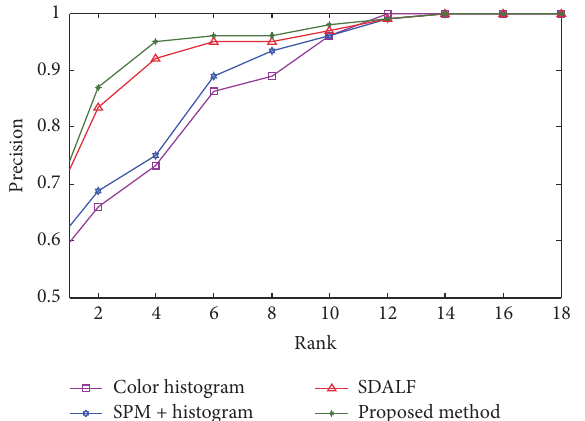
Figure 10: CMC curves on the VIPeR dataset for the proposed method and the other methods in RGB